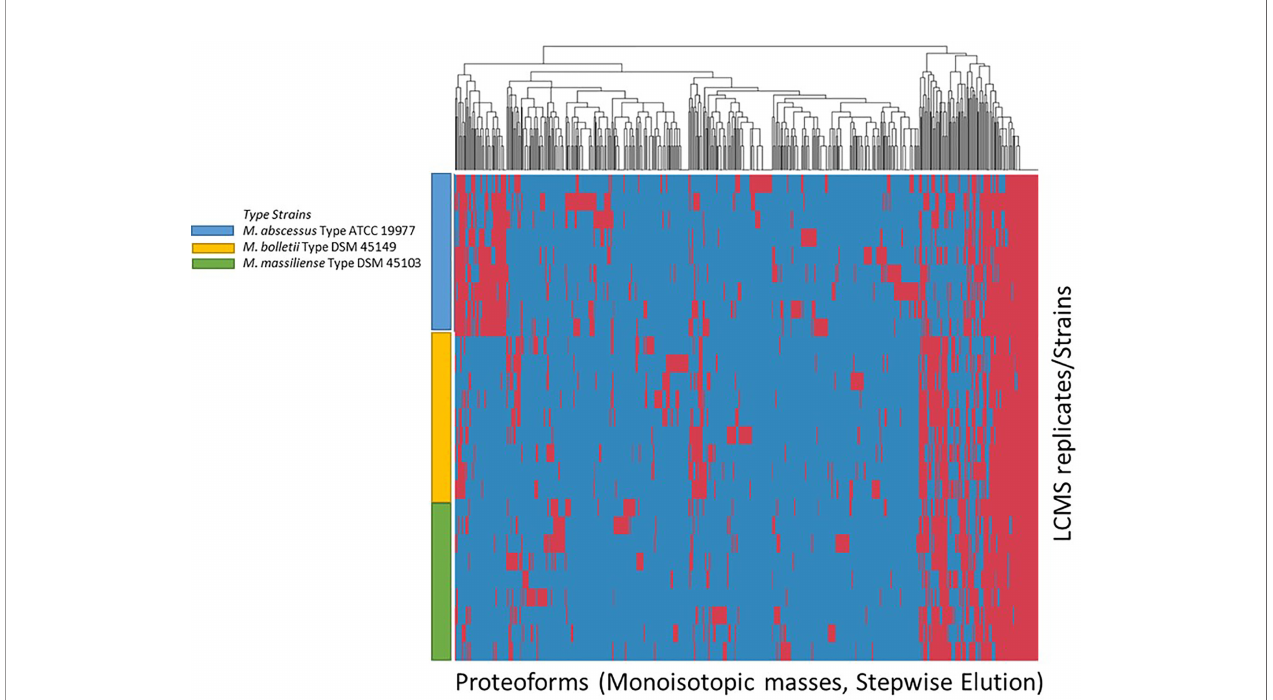
FIGURE 4 | Clustering of Proteoforms visualized as heat map for M. abscessus , M. massiliense and M. bolletii using stepwise elution with top 500 proteoforms plotted.